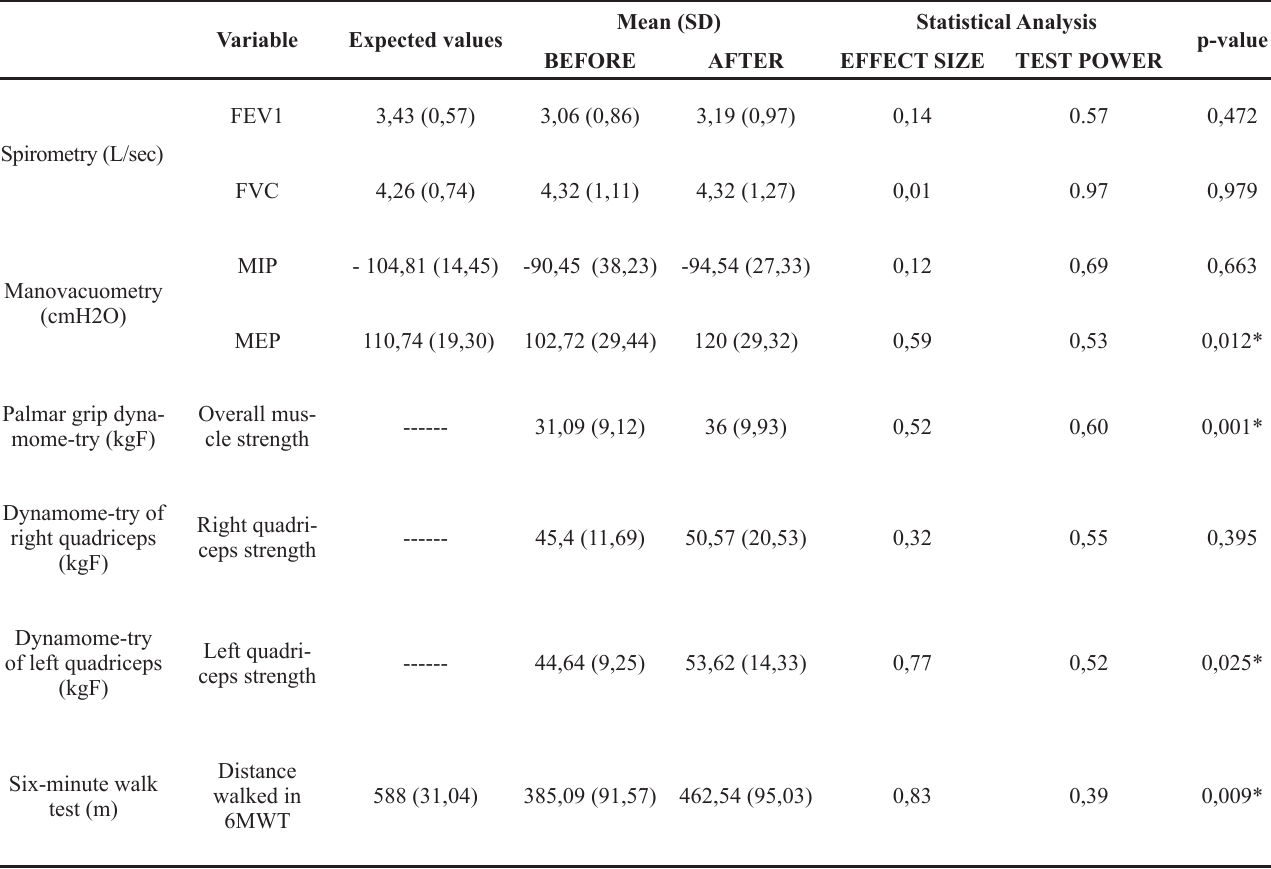
TABLE 3 - Pre- and post-intervention variables analyzed in individuals with Chronic Renal Insufficiency on hemodialysis.